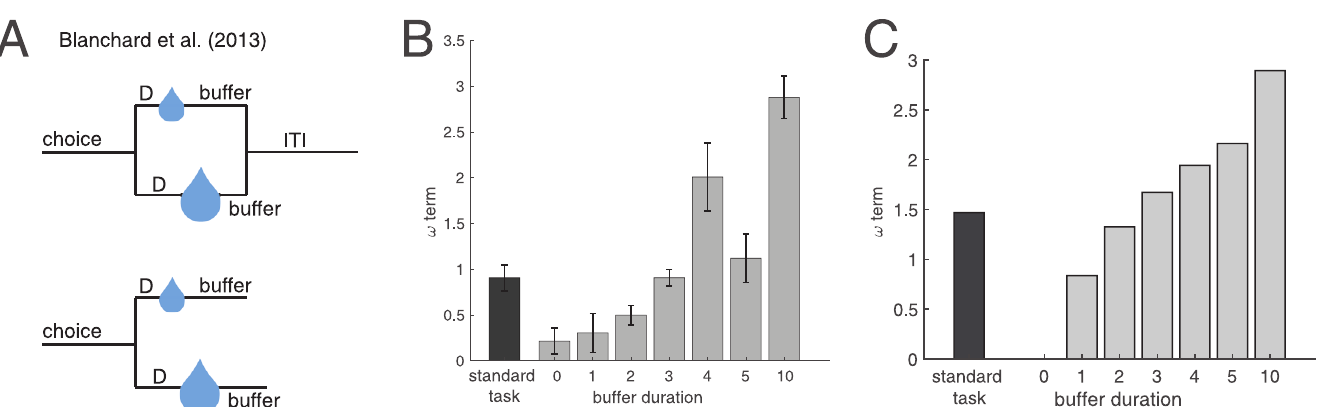
Fig 7. Rational inattention and post-reward delays. (A) Blanchard et al. [139] trained monkeys on an intertemporal choice task involving a small reward delivered soon or a large reward delivered later. Top: In the standard task, the total trial duration, or the sum of pre-reward delay (‘D’) and post-reward delay (‘buffer’), was fixed to 6 seconds. The average buffer duration was 3 seconds. Bottom: In the constant buffer task, the post-reward delay was fixed regardless of choice, and was either 0, 1, 2, 3, 4, 5, or 10 seconds. ITI: intertrial interval. (B) Monkeys underestimate post-reward delays. By fitting monkey behavior to a model in which animals maximize long-term reward rate, the authors showed that the model fit value for the subjective estimate of post-reward delay (the ‘w term,’ described in the Methods) is smaller than its true value (buffer duration). This relationship held for the standard task and across all buffer durations in the constant buffer task. For (A, B), figures adapted from [139]. (C) Our model recapitulates this effect: Under rational inattention, precision increases during the period when outcomes can be more strongly controlled (i.e., the pre-reward delay), and decreases otherwise (i.e., the post-reward delay, before the subsequent trial begins). This results in an underestimation of post-reward delays. See Methods for computational model and simulation